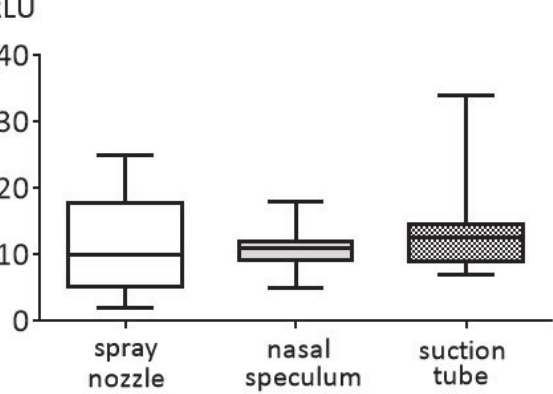
F i g . 3 Comparison of RLU scores bet w een nasal spra y nozzles, nasal spec u l u ms and s u ction t u bes before u se There w ere no statistical differences in RLU scores amon g the nasal spra y nozzles, nasal spec u l u ms, and s u ction t u bes before pa- tient u se.